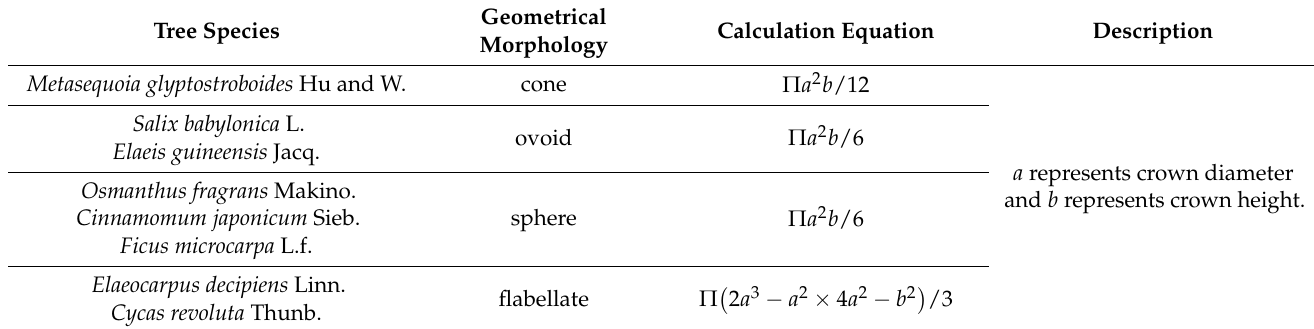
cone Π a 2 b /12